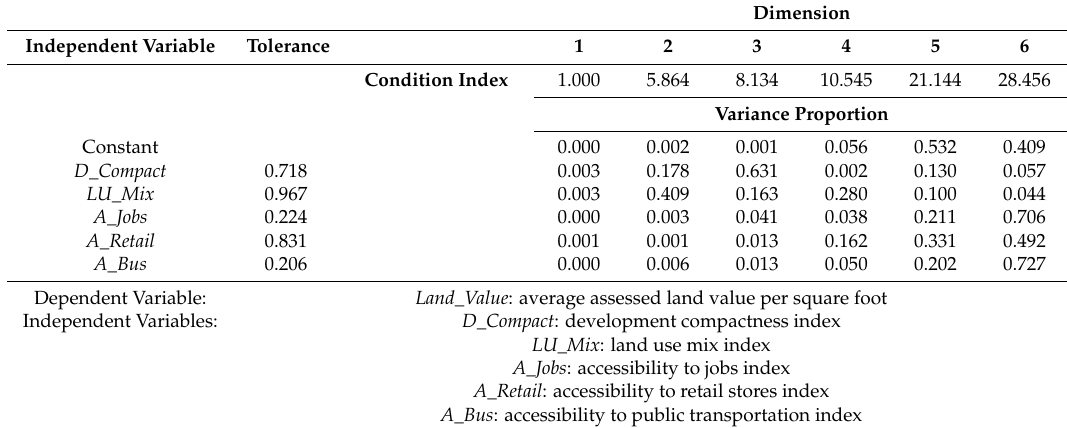
Table 4. Collinearity diagnostics of independent variables.